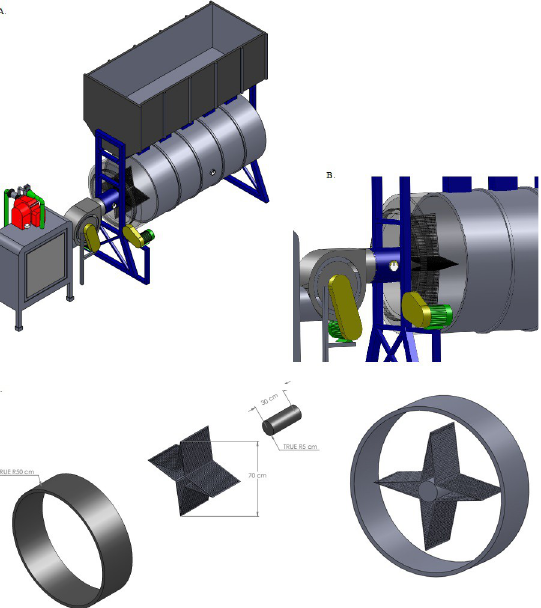
Fig 3. Top view of the horizontal rotary dryer, with installed diffusion system (A), development of drying air diffuser in rotary dryer (B), detail of the diffusor (C).